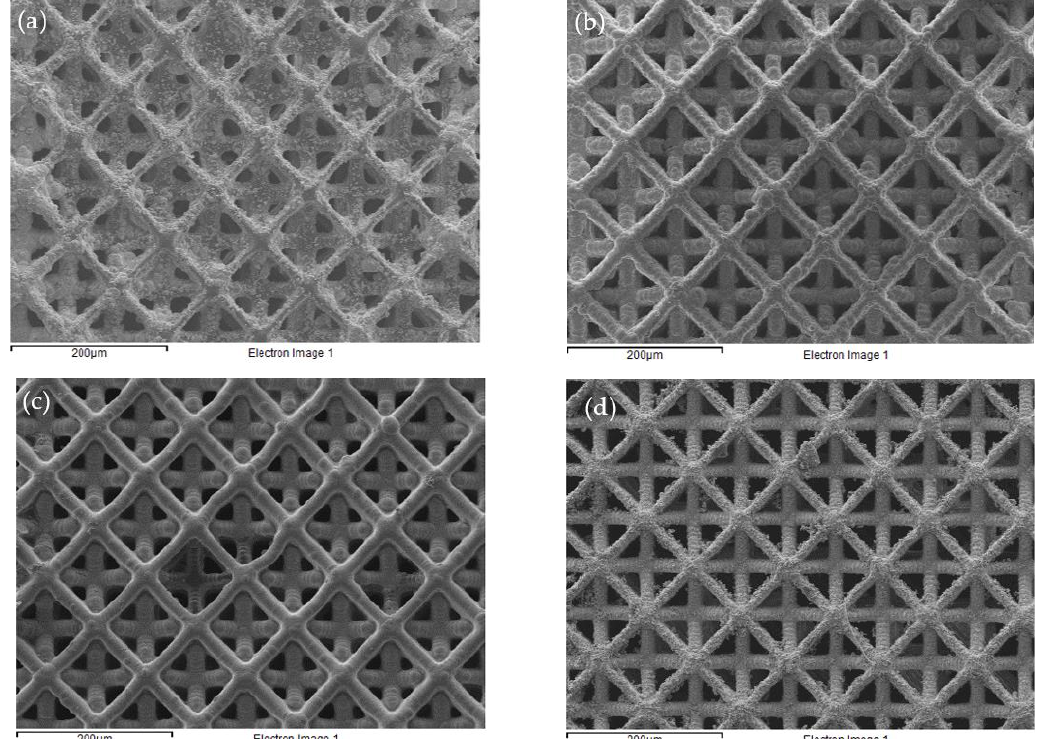
Figure 6. Top view of the electroless plated micro-lattice structures following pretreatment of ( a ) dip coating in carbon nanotube; ( b ) dip coating in graphene; ( c ) aluminum sputtering; ( d ) palladium chloride activating. Table 2. Dimensional changes after electroless nickel plating using different pretreatments.